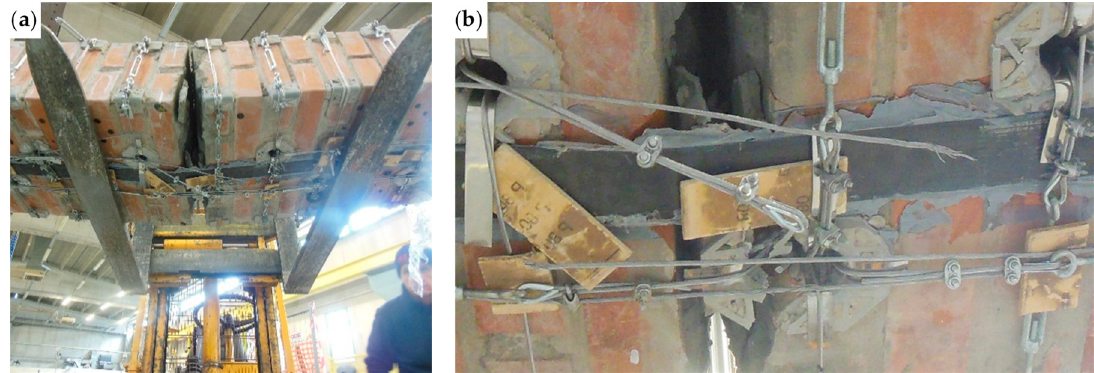
Figure 48. The specimen on the forklift after the test: ( a ) bottom/back view (the vertical white marks indicate the middle cross-section) and ( b ) detail of the disconnected cross-section viewed from below, with the Flemish eye that came out of the threaded eyebolt in the foreground.